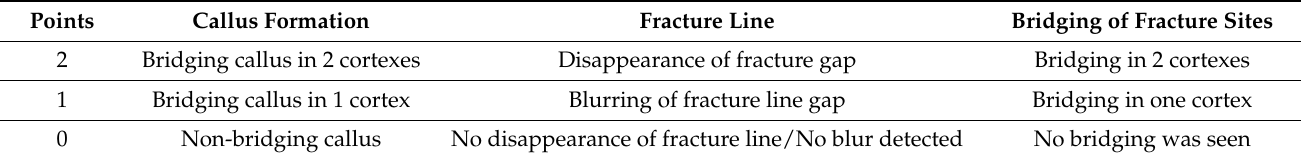
Table 1. Grading system for the parameters under investigation.